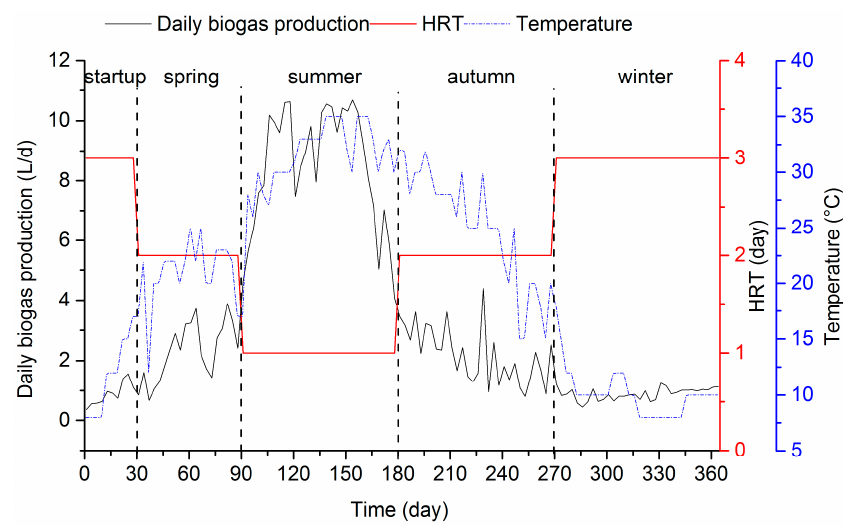
Figure 4. Biogas production in the system during the whole operation.